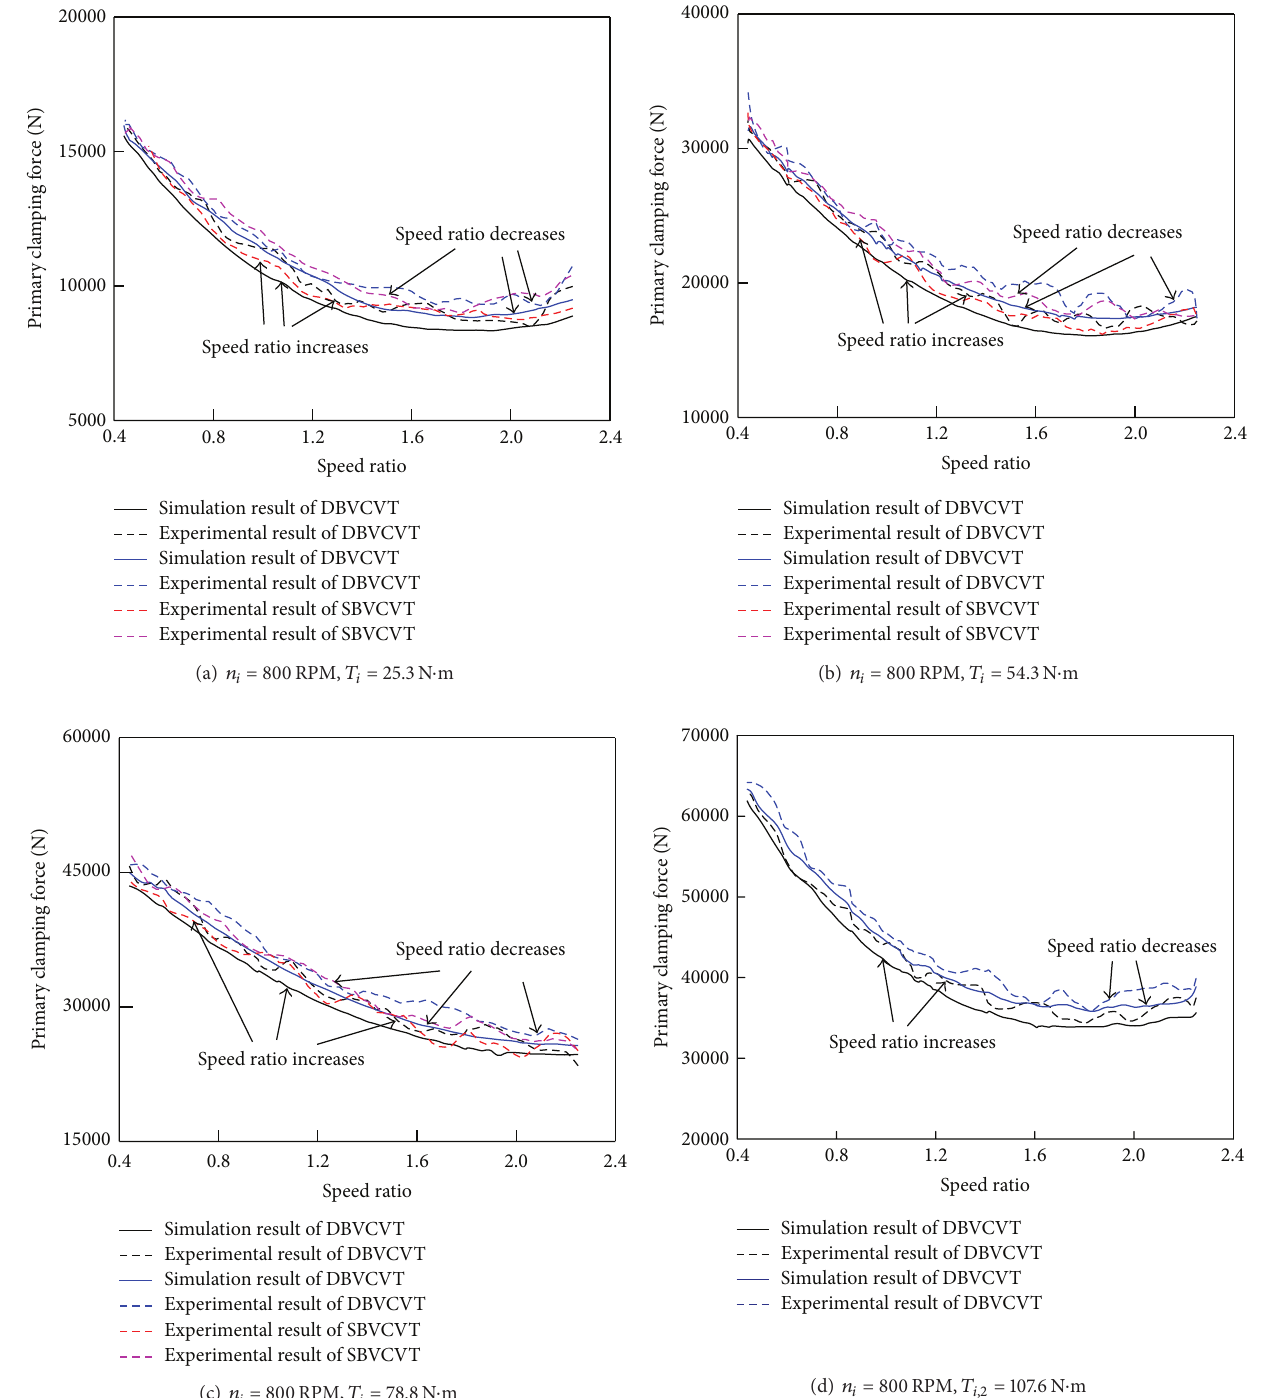
Figure 8: Comparison of simulation and experimental results of speed ratio responses under 𝑛 𝑖 = 800 RPM.